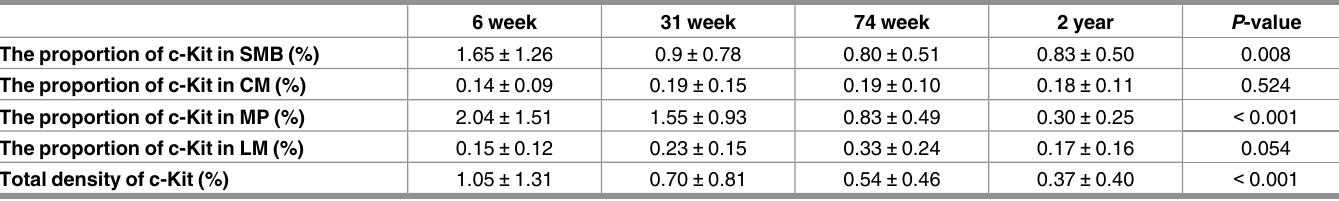
Table 1. The proportion of the c-Kit positive area in the corpus of four different aged rat stomach (all, n =